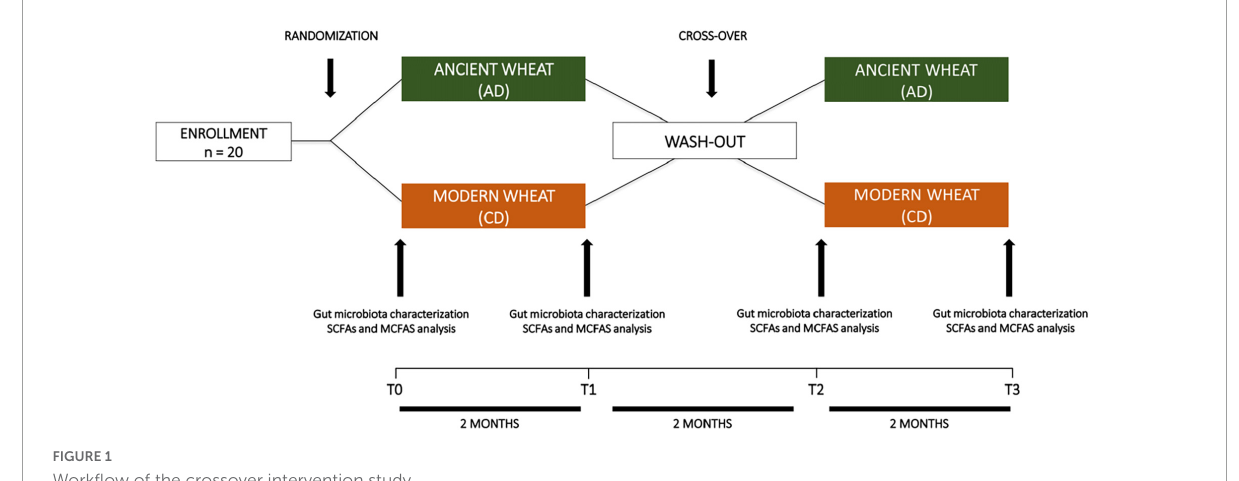
FIGURE1 Workflow of the crossover intervention